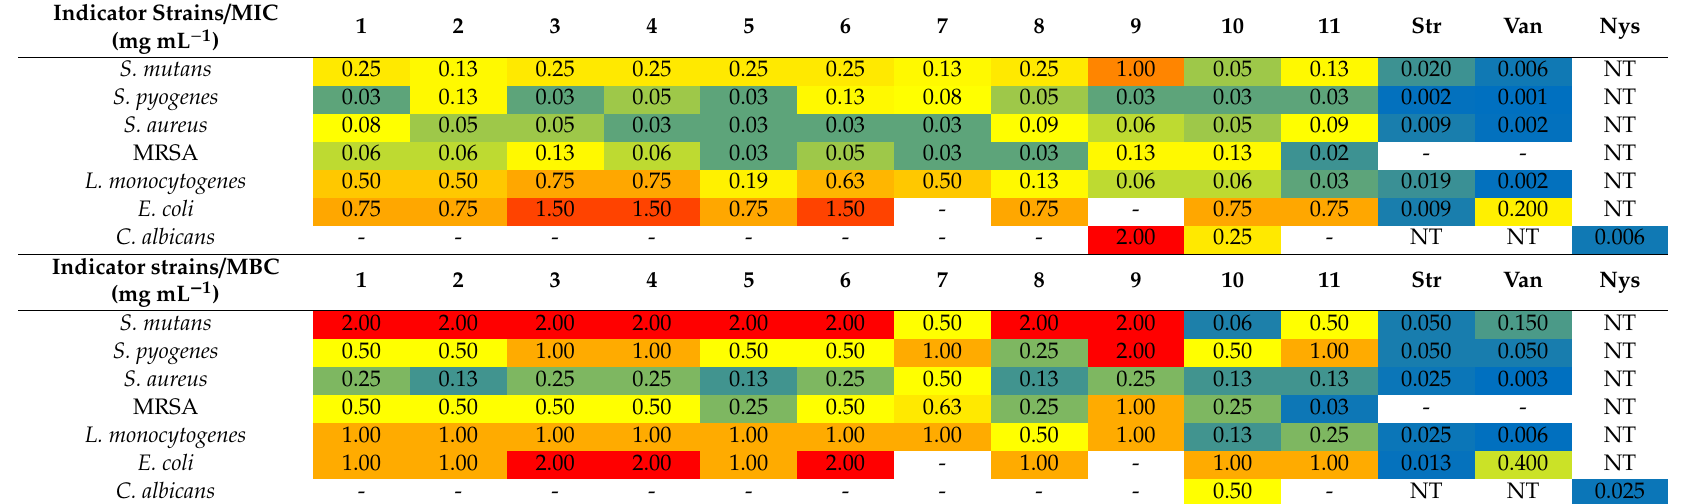
Table 3. Minimum inhibitory, minimum bactericidal and minimum fungicidal concentrations (MIC / MBC / MFC) of 11 wood extracts towards selected human pathogens (mg mL − 1